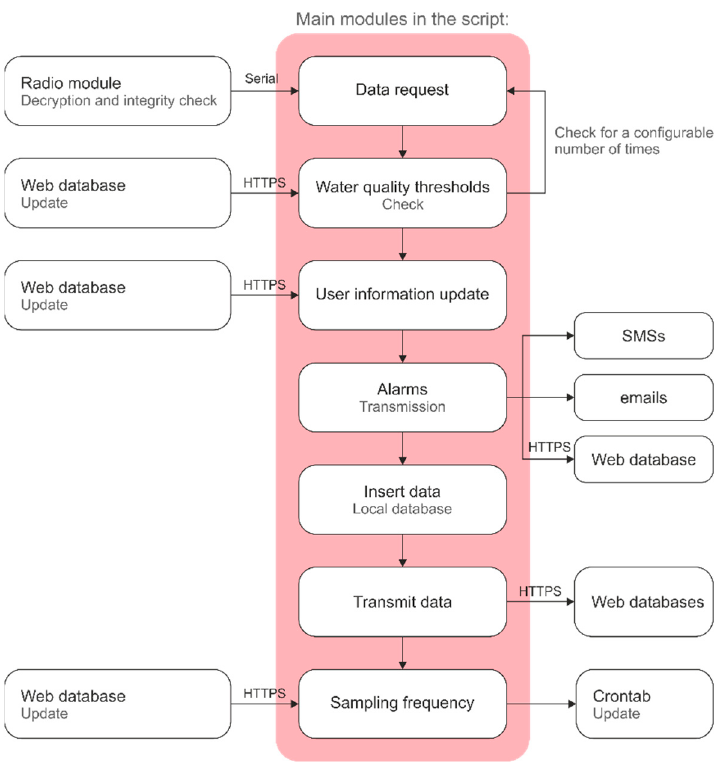
Figure 7. Architecture and sequential modules in the main script of the gateway.